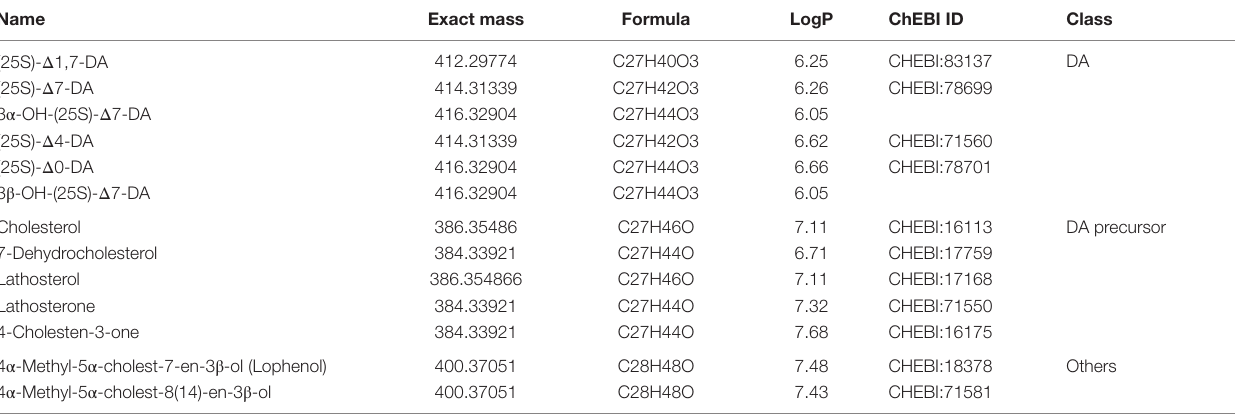
TABLe 1 | Molecular properties of dafachronic acids and known precursor substances.